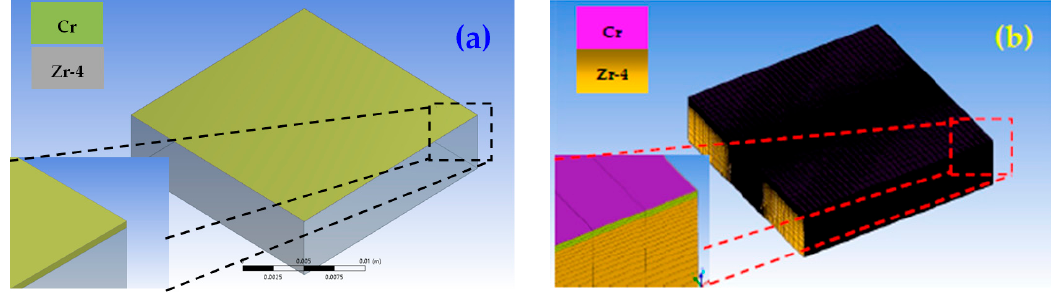
Table 2. Thermophysical properties of Cr and Zr-4 alloy [30].